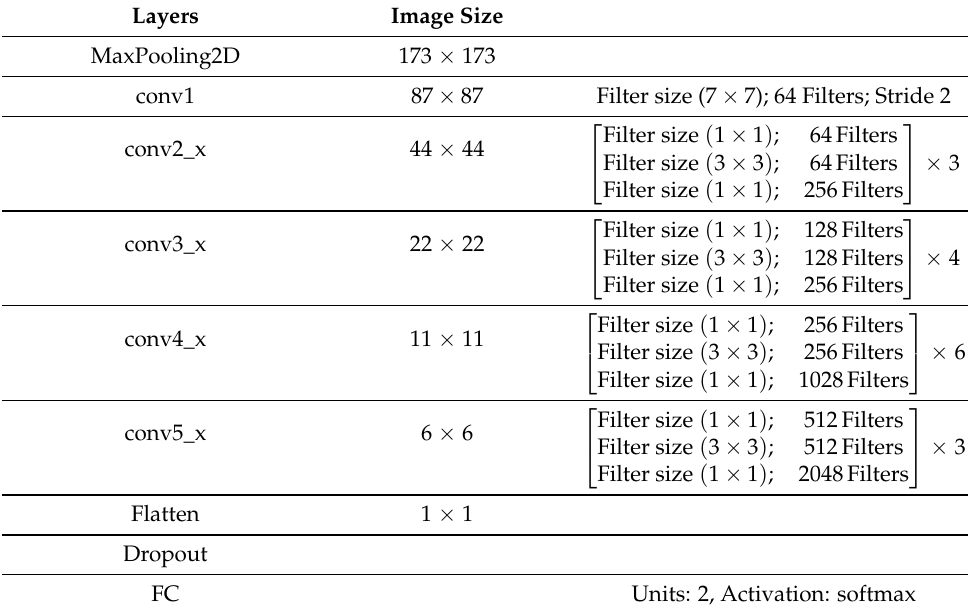
Table 4. The structure of